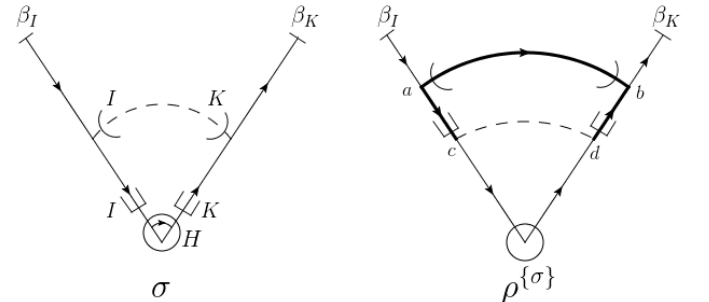
Figure 8. A pinch surface (cid:27) that yields a hard-exotic con(cid:12)guration in (cid:26) f (cid:27) g , where the hard subgraph is disconnected in the latter. Here we use bold lines and arcs to denote hard propagators, and dashed arcs to denote soft propagators. Due to the hard-collinear approximations from t (cid:27) , only the (cid:12) I - and (cid:12) K -components of the hard momenta (cid:13)ow into vertices c and d in (cid:26) f (cid:27) g separately. So IR structures can emerge in the subgraph with these lightlike momenta being the external